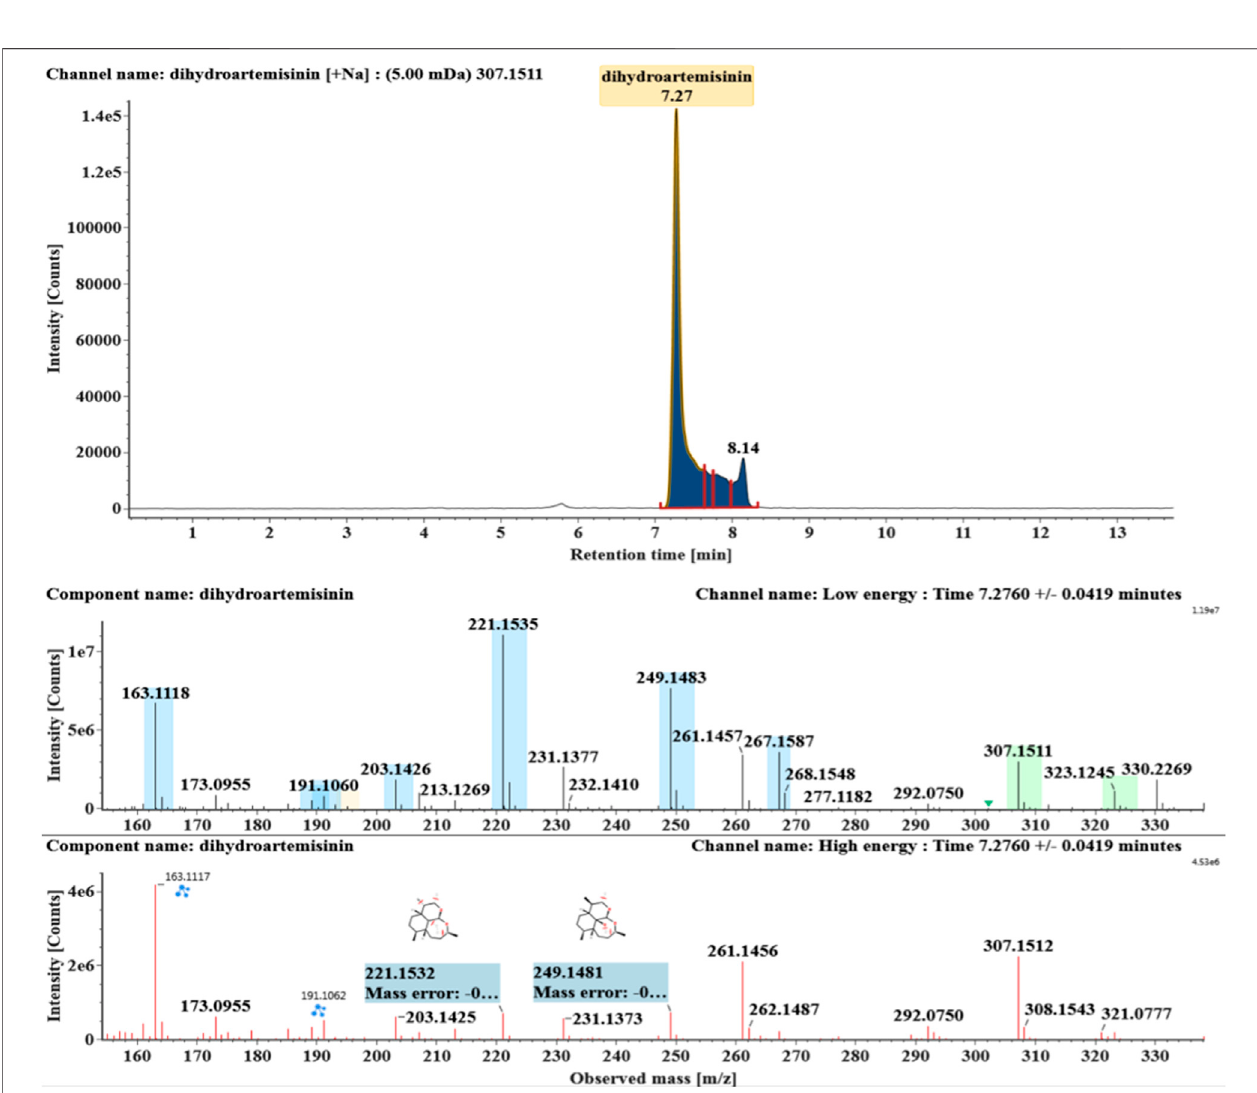
FIGURE 1 | Extracted ion chromatograms and mass spectrometry (MS E ) spectra of DHA.